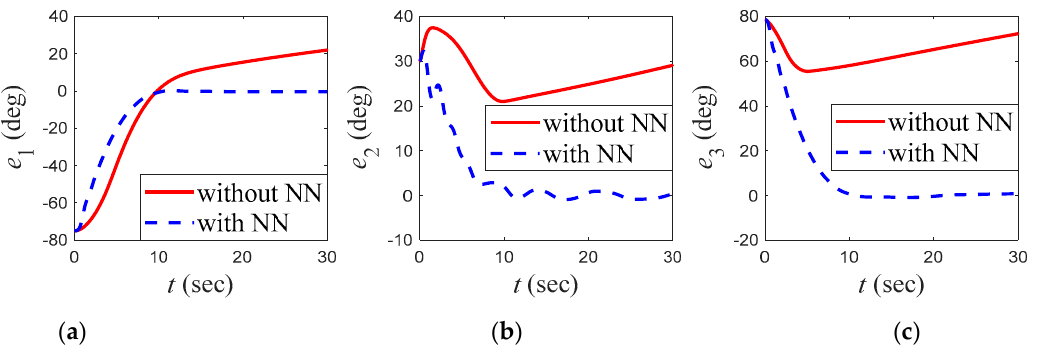
Figure 15. Comparison of angle tracking errors under control laws with or without NN. ( a ) The first value of the angle tracking errors; ( b ) The second value of the angle tracking errors; ( c ) The third value of the angle tracking